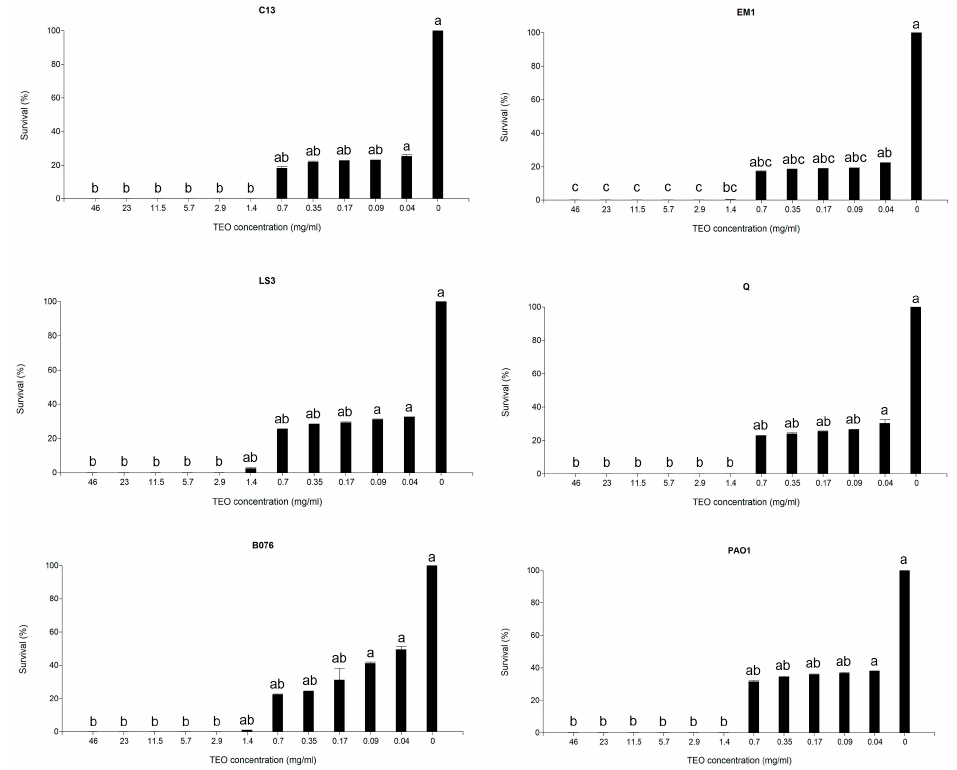
Figure 4. The effect of different concentrations of TEO on sessile cell survival (%), as observed in P. syringae C13, P. syringae EM1, P. syringae LS3, P. syringae Q, P. savastanoi pv. glycinea BO76, and P. aeruginosa PAO1. The results are expressed as the mean ± standard error (SEM) of survival (%). Means with different letters indicate statistically significant differences ( p < 0.05). Lowercase letters compare the control (0 mg/mL) and the strains treated with different concentrations of